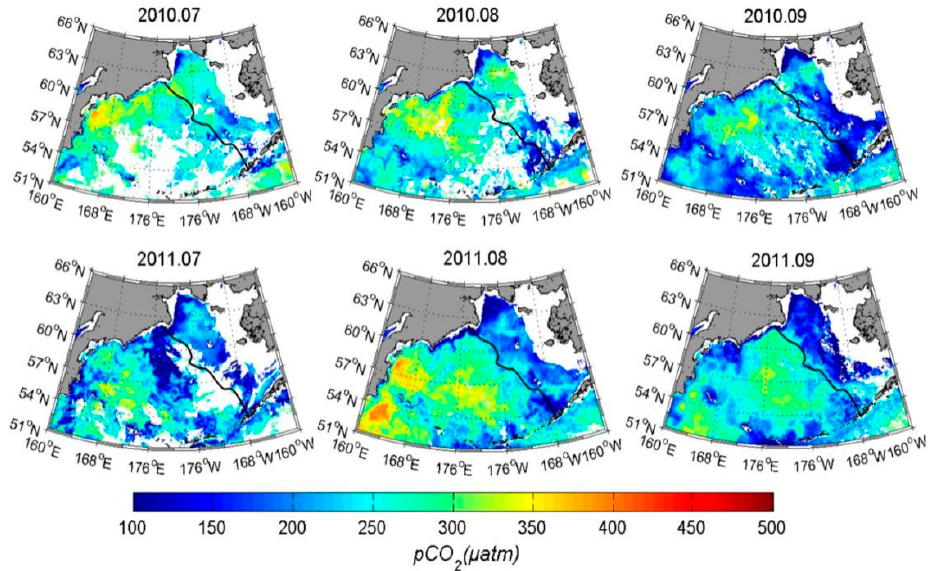
Figure 5. Monthly average satellite-derived p CO 2 from July to September in 2010 and 2011. The black line represents isobaths of the 200 m depth, and the coastal areas shallower than 50 m depth are masked.